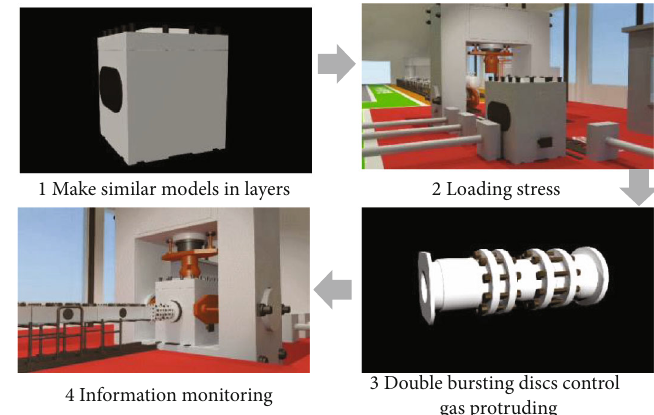
Figure 3: The schematic diagram of the experimental process.